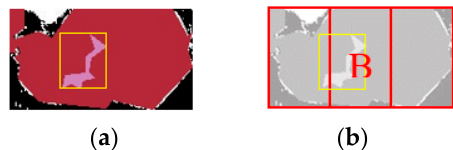
Figure 14. Steps to determine the type of fracture in case of a line fracture: ( a ) The region of the fracture